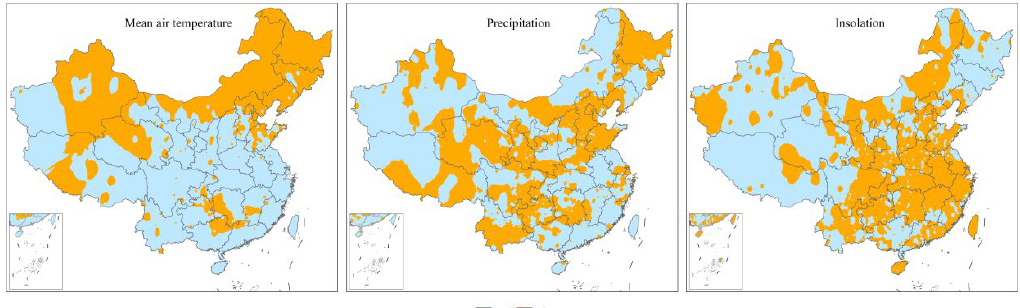
Figure 10. Difference between the change in factors (mean air temperature, precipitation, and inso- lation) during the potential agricultural growing season in 1991–2020 relative to 1961–1990 and the change in factors (mean air temperature, precipitation, and insolation) during the whole year in 1991–2020 relative to 1961–1990.